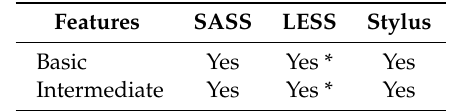
Table 6. Loop features’